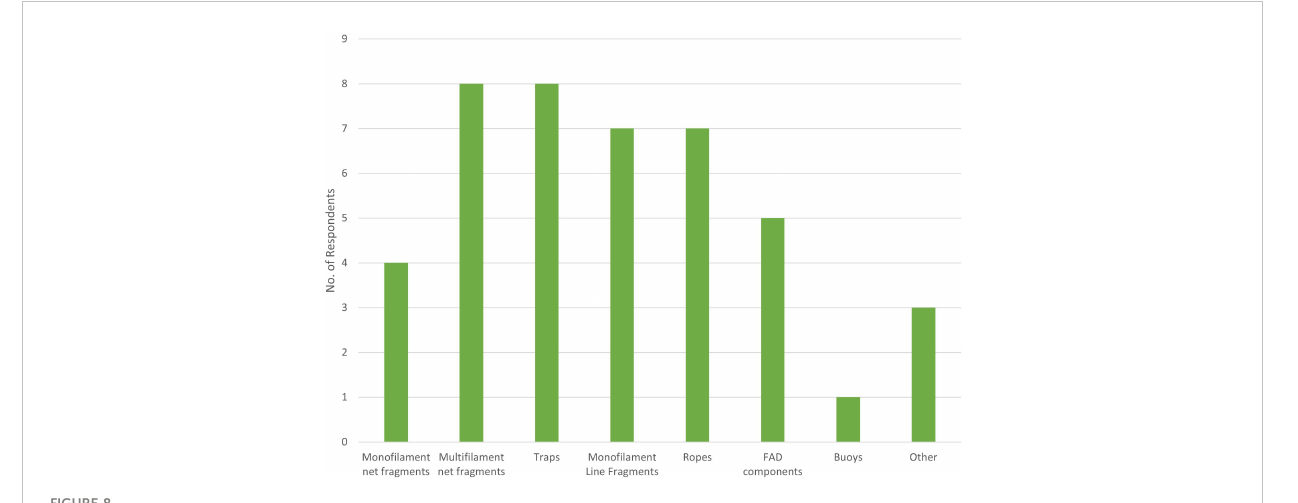
FIGURE 8 Categories of ALDFG encountered by divers in Antigua and Barbuda (n =